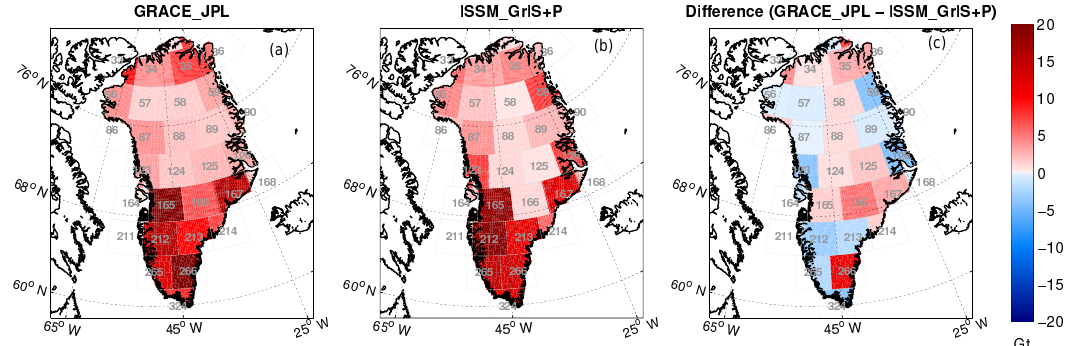
Figure 5. Spatial representation of annual amplitude of surface mass over Greenland from (a) GRACE_JPL, (b) ISSM_GrIS+P, and (c) the difference between GRACE_JPL and ISSM_GrIS+P.